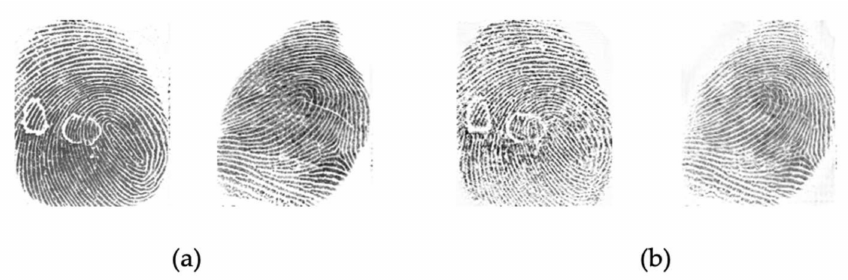
Figure 10. Image conversion from Crossmatch domain ( a ) to the joint domains ( b ) of other sensors. Figure 11 shows the evolution of the training loss of the generator and discriminator of CycleGAN on the Livdet2015 dataset over